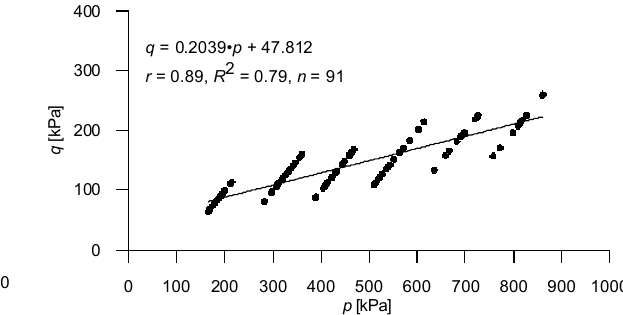
Figure 14: Result of strength tests for soil A-3.